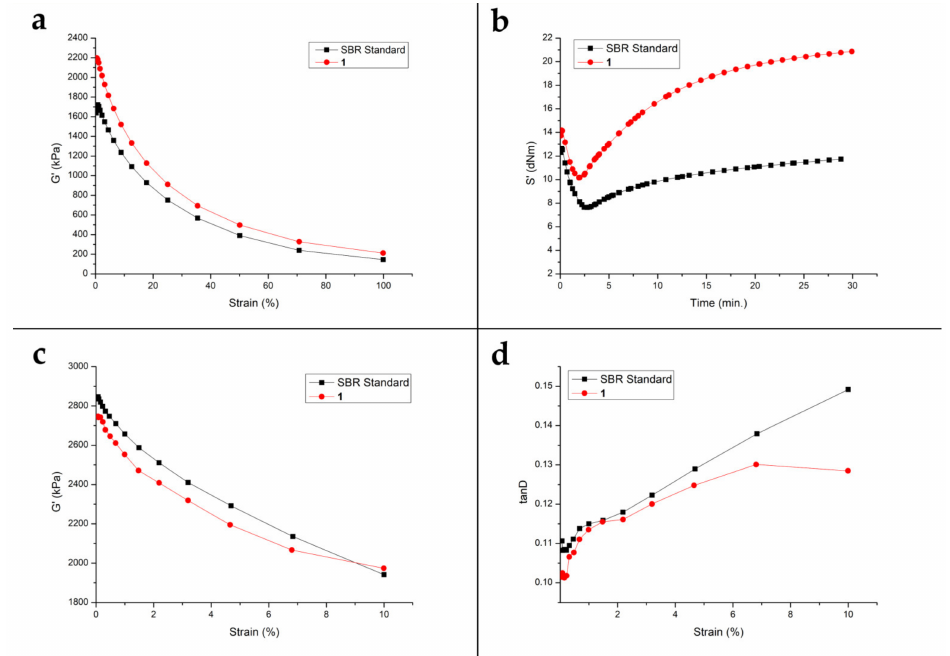
Figure 5. Dynamic mechanical properties of first stage compound treated with bistetrazole 1 com- pared to first stage standard SBR. ( a ) G’ measured before curing; ( b ) S’ at 190 ◦ C; ( c ) G’ measured after curing at 190 ◦ C; ( d ) tan delta after curing at 190 ◦